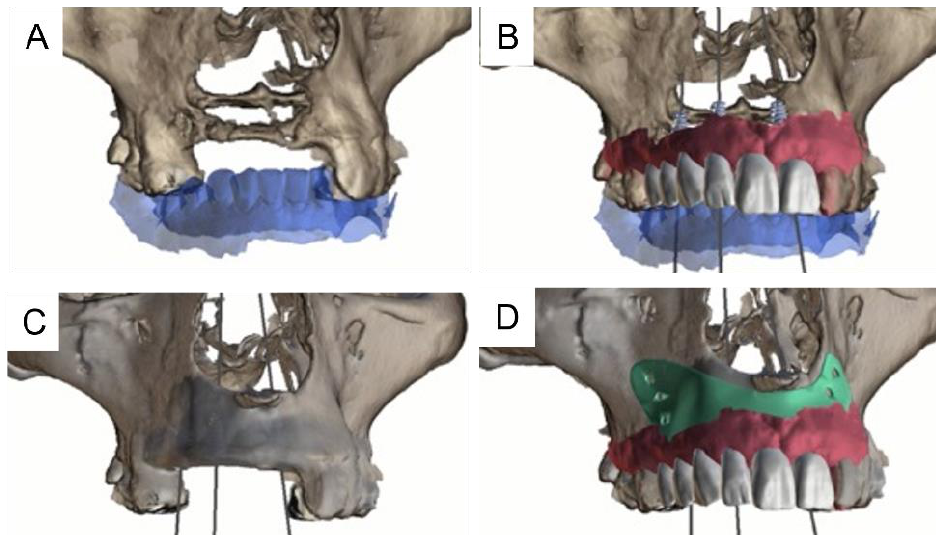
Figure 5. Virtual planning of the second case. Bone status after segmentation from pre-operative CBCT data coupled with the inferior arcade profile from STL data ( A ); the final prediction of rehabilitation according to the simulated ideal prosthetic and gingival profile ( B ); simulation of the necessary bone volume ( C ); the membrane design according to bone volume and final mucosal and prosthetic result ( D ).